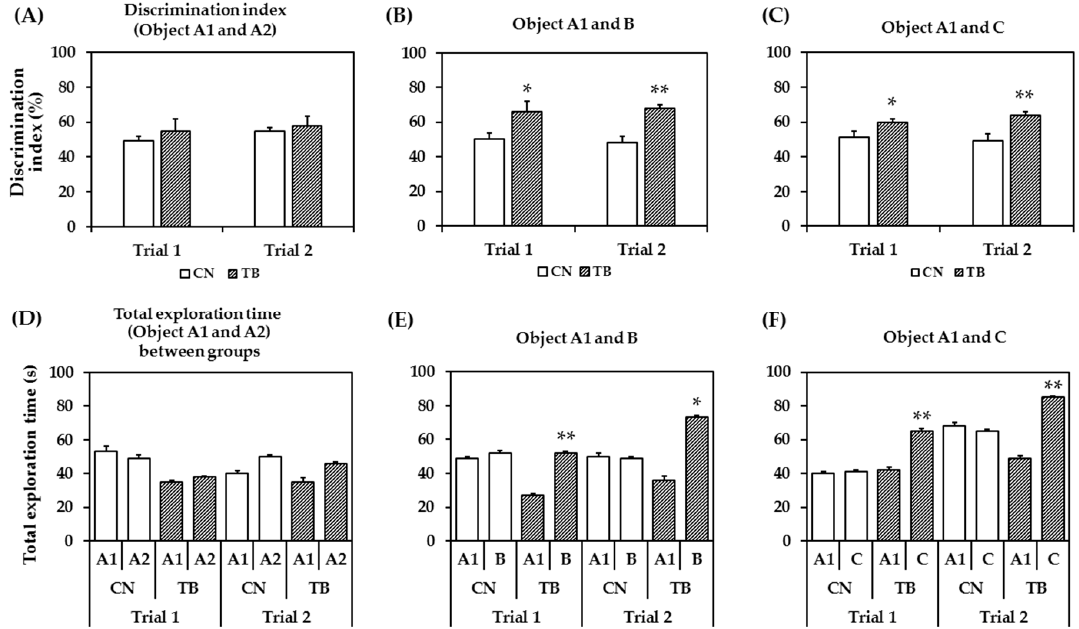
Figure 6. The effect of theobromine (TB) on memory performance assessed by the novel object recognition (NOR) test. The discrimination index (DI) for exploring the object A1, A2 (A); object A1, B (B); and object A1, C (C). Both DIs (Object A1, B and Object A1, C) were significantly greater in TB-fed rats (TB rats) in 2 trials. Values are the mean ± S.E.M. ( n = 5 for each group). * p < 0.05, ** p < 0.01; significant difference between groups. Total exploration time for same object (object A1, A2) (D); total exploration time for each object (object A1, B) (E); and total exploration time for each object (object A1, C) (F). TB rats stayed significantly longer time at the new object B and C in 2 trials. Values are the mean ± S.E.M. ( n = 5 for each group). * p < 0.05, ** p < 0.01; significant difference between A1 and B or C.